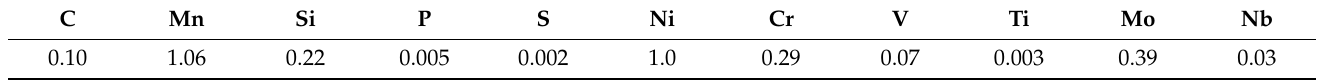
Table 1. Chemical elements of the X80 heavy-wall seamless pipeline steel